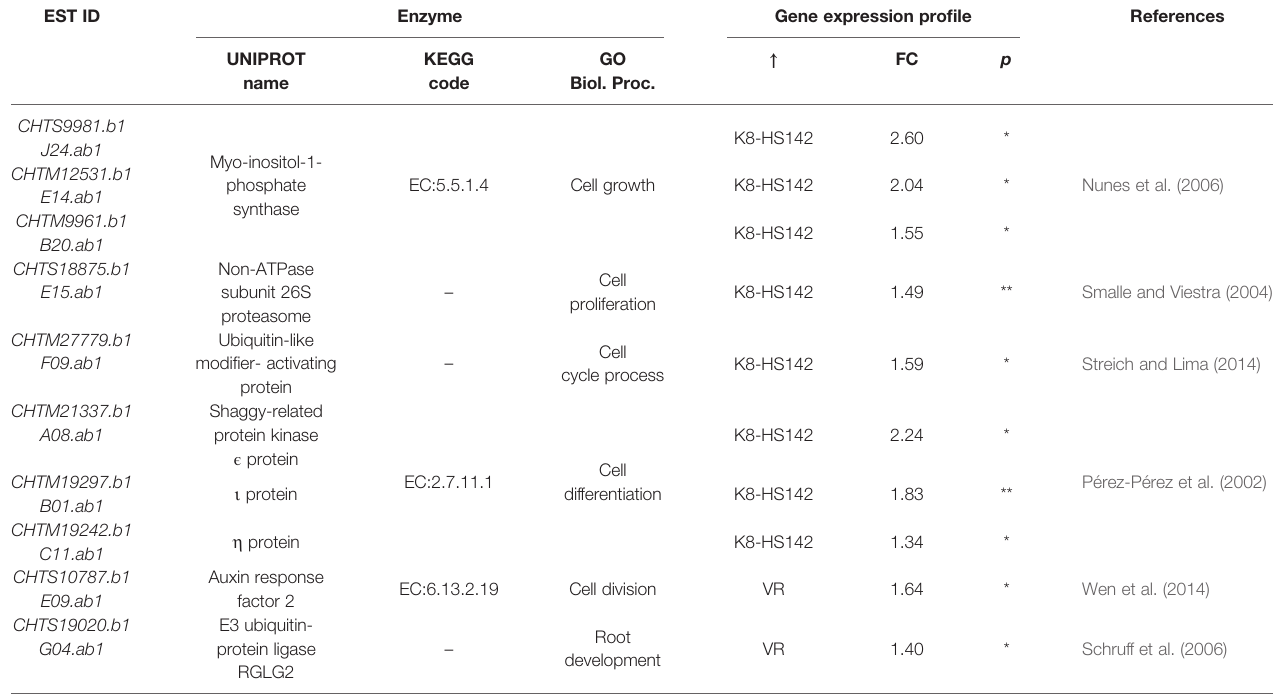
TABLE 4 | DE/ESTs between clones at T 0 taking a role in cell development. EST